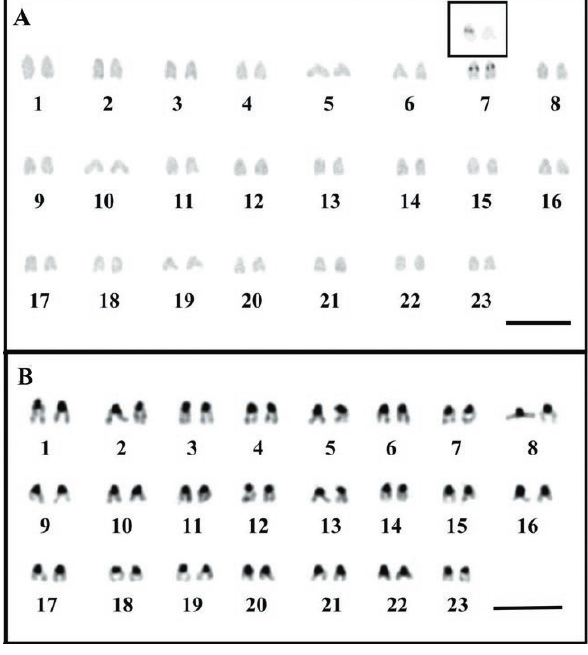
Figure 3. Karyotypes of Trichopodus microlepis , 2 n =46 by Ag-NOR banding (A) and C-banding techniques (B). The chromosome pair 7 show Ag-NOR and heteromorphic Ag-NOR (inserted box). Scale bars = 5